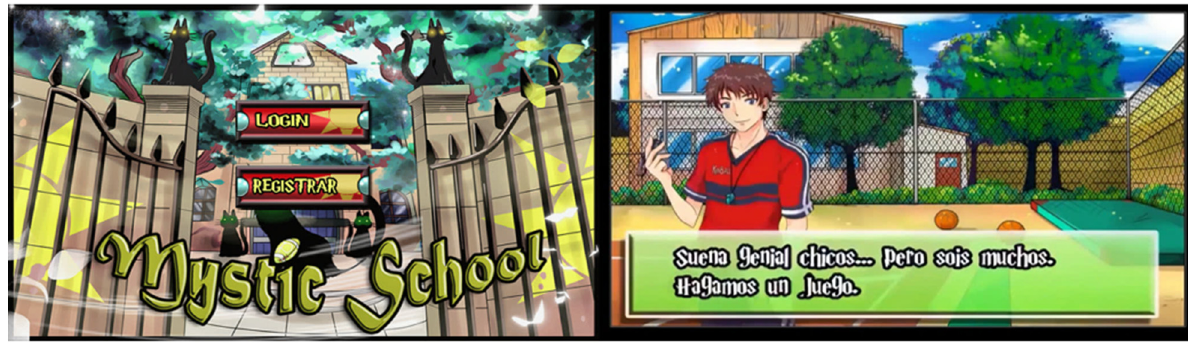
Figure 1. Registration in the video game and first explanation screen (Spanish version).